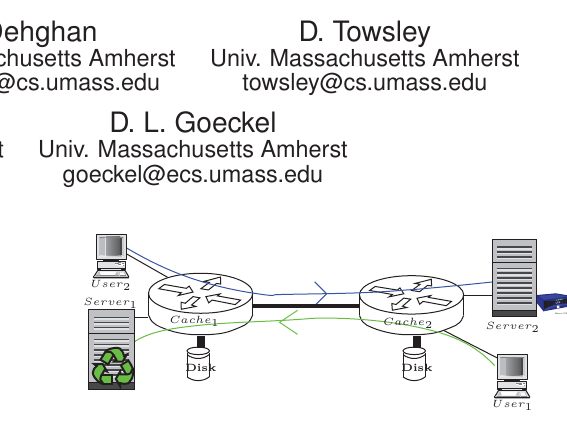
Figure 1: Tandem of two caches with bidirectional